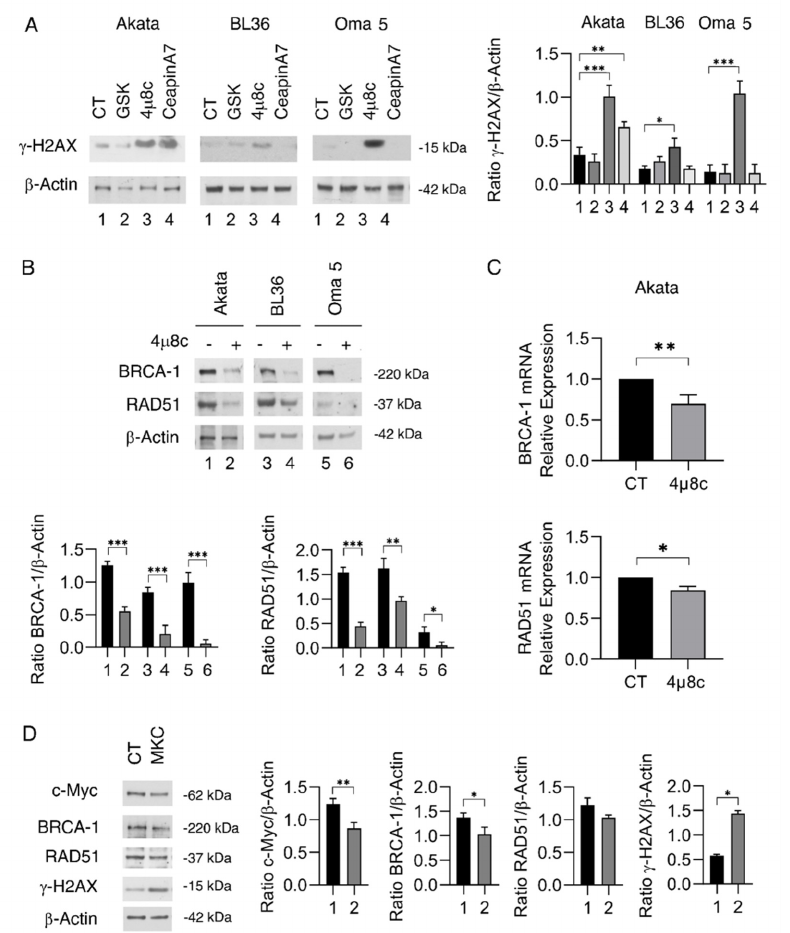
Figure 3. IRE1-alpha inhibition by 4 µ 8C impairs DNA repair in BL cells . Akata, BL36, and Oma 5 cells were treated with GSK2606414 (GSK) (0.5 µ M), 4 µ 8C (15 µ M), or CeapinA7 (12 µ M) for 24 h. Untreated cells were used as control (CT). ( A ) Protein expression level of γ -H2AX was evaluated by Western blot analysis. β -Actin was used as loading control and one representative experiment is shown. The histograms represent the densitometric analysis of the ratio of γ -H2AX/ β -Actin of three different experiments. Data are represented as the mean plus S.D. ( B ) Akata, BL36, Oma 5 cells were treated or not with 4 µ 8C (15 µ M) for 24 h. Protein expression level of BRCA-1 and RAD51 was evaluated by Western blot analysis. β -Actin was used as loading control and one representative experiment is shown. The histograms represent the densitometric analysis of the ratio of specific protein and β -Actin of three different experiments. Data are represented as the mean plus S.D. ( C ) qRT-PCR of BRCA-1 and RAD51 in Akata cells treated or not with 4 µ 8C (15 µ M) for 24 h. Data are expressed relative to reference gene B2M. The histograms represent the mRNA expression levels of BRCA-1 and RAD51 genes of three different experiments. Data are represented as the mean relative to the control plus S.D. ( D ) Akata cells were treated with MKC-8866 (MKC) (30 µ M) for 24 h. Protein expression level of c-Myc, BRCA-1, RAD51, γ -H2AX was evaluated by Western blot analysis. β -Actin was used as loading control and one representative experiment is shown. The histograms represent the densitometric analysis of the ratio of specific protein and β -Actin of three different experiments. Data are represented as the mean plus S.D. p value: * p < 0.05; ** p < 0.001; *** p <